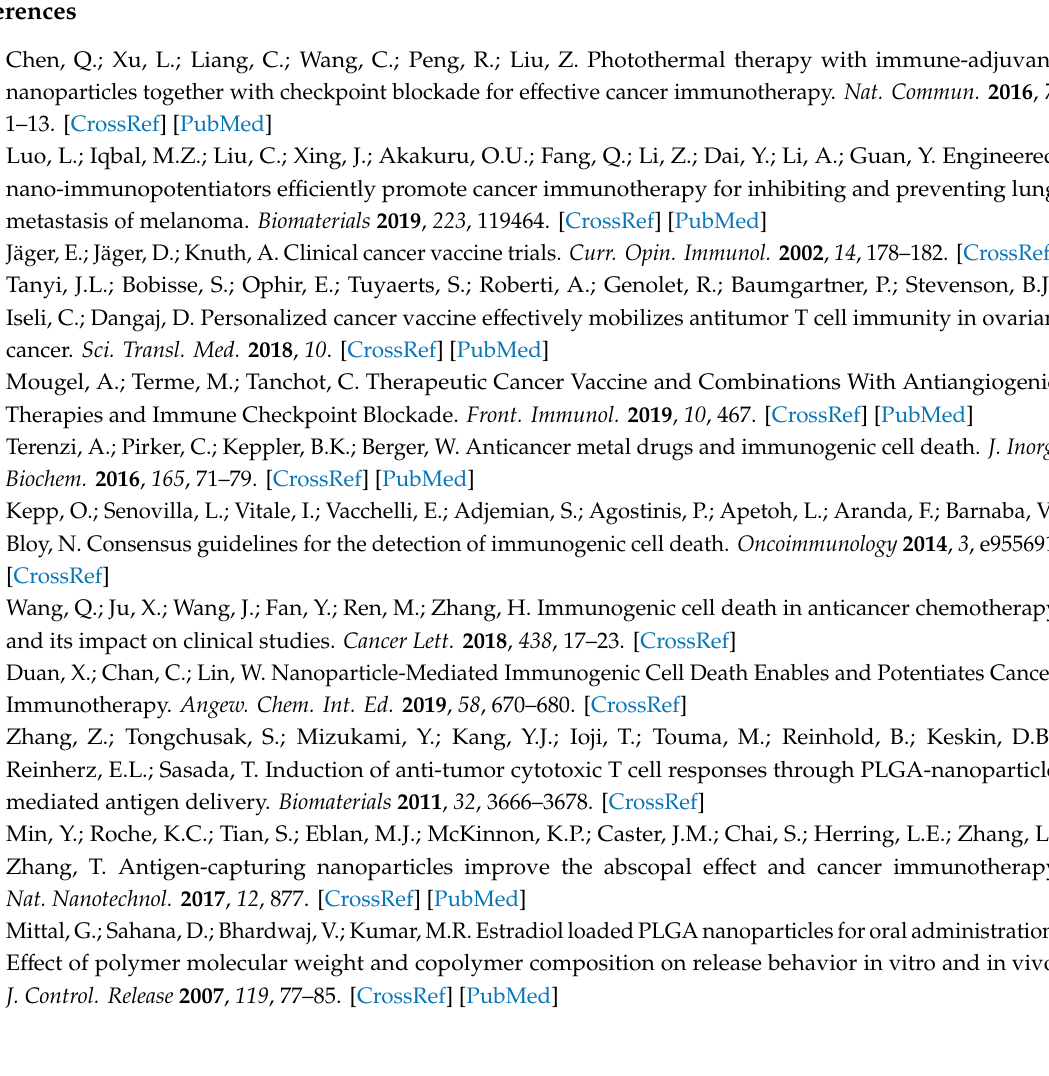
Figure S1: Magnified time-dependent cellular uptake images of DOX-HCl-, FITC-labeled DOX-PLGA7K NP-, and FITC-labeled DOX-PLGA12K NP-treated CT-26 tumor cells. Blue channel: DAPI, Red channel: DOX, Green channel: FITC-labeled PLGA NPs. The scale bar indicates 5 µ m, Figure S2: ( A ) The cell viability of CT-26 tumor cells treated with various concentrations 0.1 to 100 µ g / mL of PLGA7K NPs and PLGA12K NPs for 48 h. ( B ) Western blot image and band intensity of HMGB1 which was released in the cell culture medium. CT-26 tumor cells were treated with DOX-HCl, DOX-PLGA7K NPs (5 µ M of DOX), or PLGA7K NPs for 48 h, Figure S3: Whole-body DOX fluorescence images of the CT-26 tumor-bearing mice, Figure S4: ( A ) In vivo survival rate of the CT-26 tumor-bearing mice after PBS, DOX, DOX-PLGA7K NP, and DOX-PLGA12K NP treatment. ( B ) In vivo survival rate after a CT-26 tumor cell re-challenge in the tumor-suppressed mice that were treated with DOX-HCl-, DOX-PLGA7K NPs, or DOX-PLGA12K